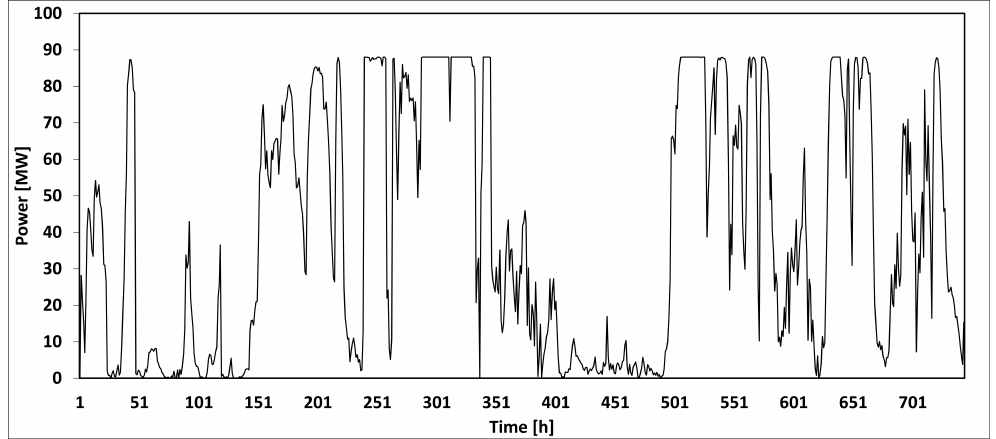
Figure 1. Wind power time series data during January